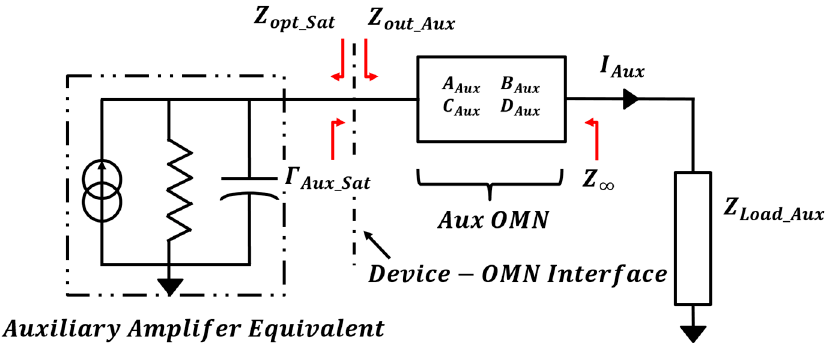
Figure 11. The half circuit equivalent for the Auxiliary Amplifier section of the Doherty Amplifier.